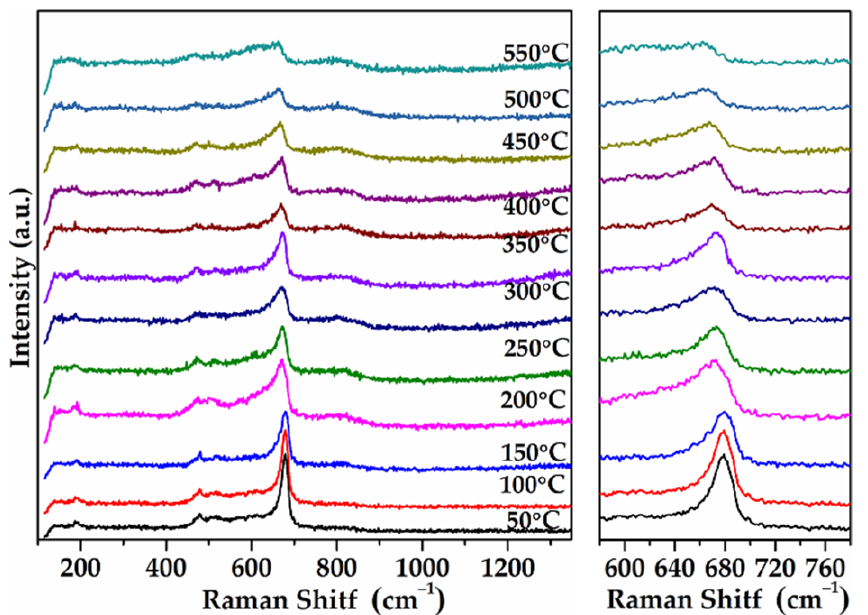
Figure 11. In-situ Raman spectra of Mn 0.7 K 0.3 Co 2 O 4 -HC catalyst under laser wavelength of 532 nm. Reaction conditions: heating rate was 2 °C/min. The reaction atmosphere contained NO (2000 ppm), O 2 (10%) and He as equilibrium gas, and the total flow rate was 50 mL/min. Monolith catalyst maintains loose contact with soot.